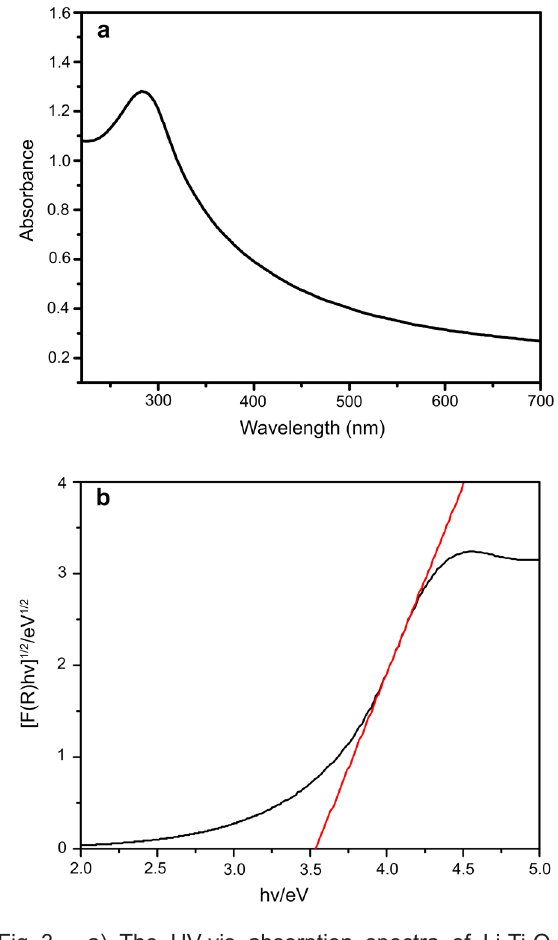
Fig. 3. a) The UV-vis absorption spectra of Li b) TheTauc plot for L